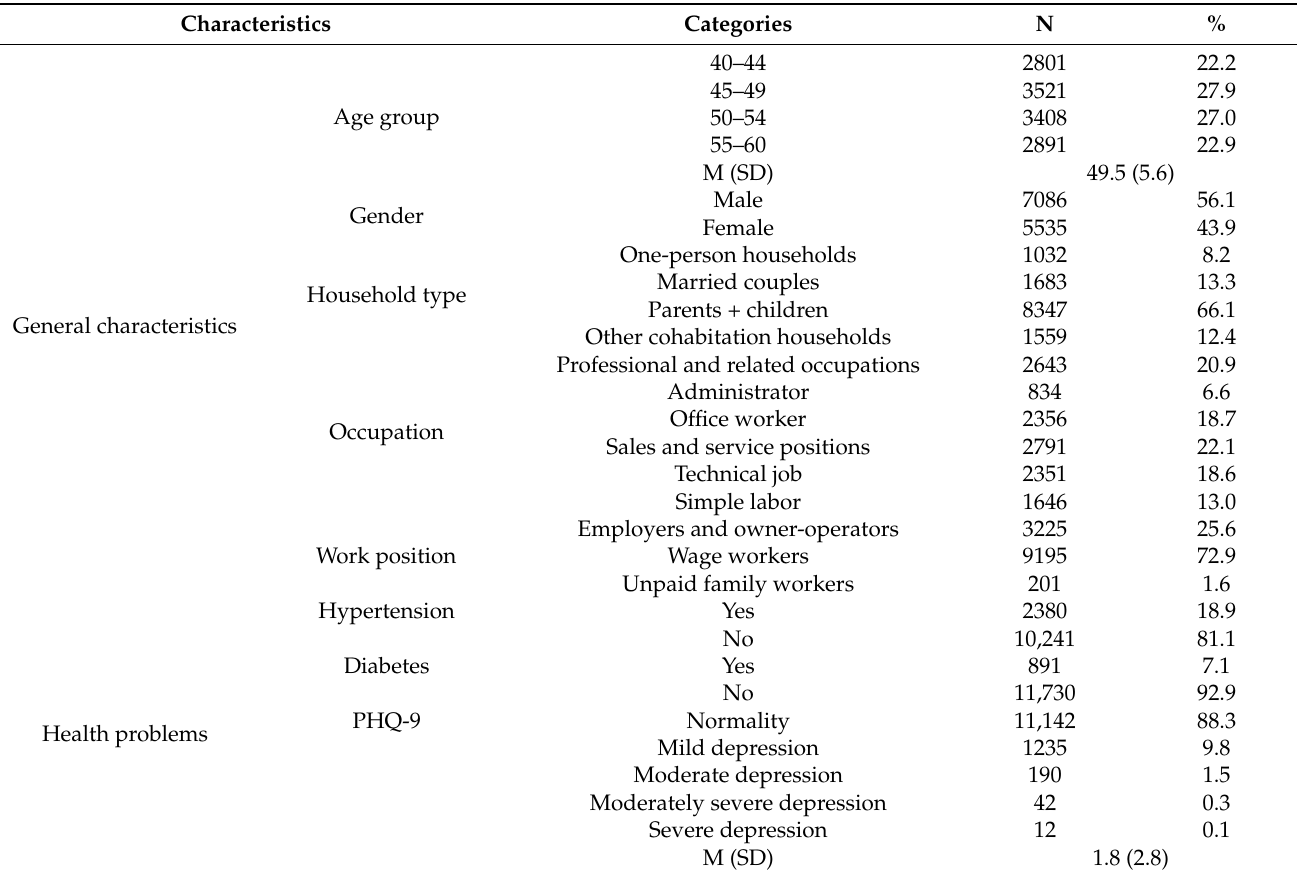
Table 1. General characteristics and health problem characteristics of